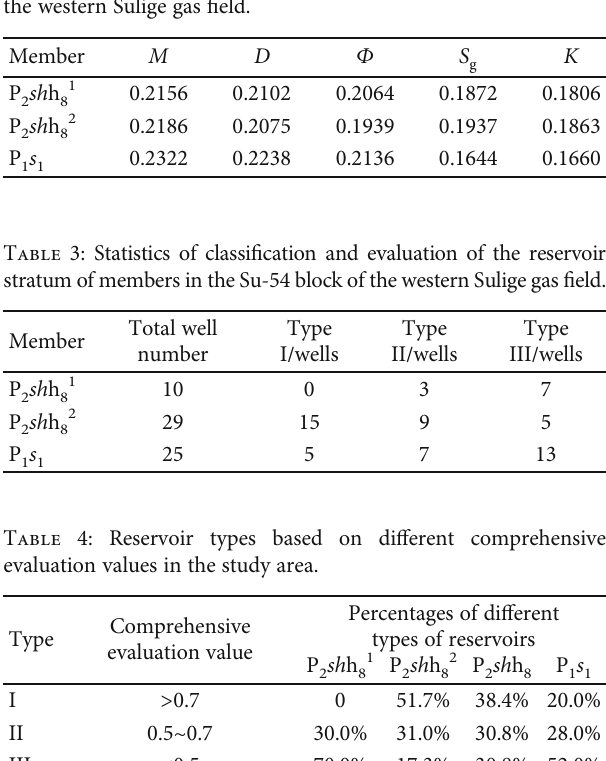
sh h 82 , the Su-54 block, western 2